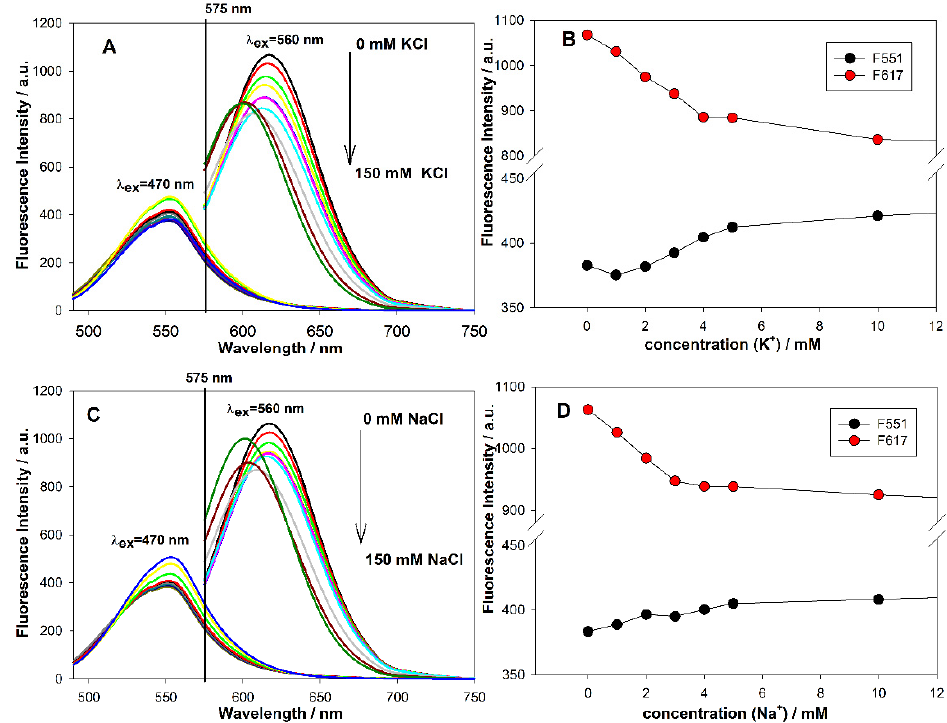
Figure 7. Effect of cations on fluorescence properties of TBAC12-AgNCs: ( A ) emission spectra in presence of increasing K + concentration; ( B ) changes in maximum intensity of green and red fluorescence upon K + addition; ( C ) emission spectra in presence of increasing Na + concentration; ( D ) changes in maximum intensity of green and red fluorescence upon Na + addition. Conditions: 2 μ M probe in 10 mM Tris-acetate (pH = 7.5) after 24 h since silver reduction.